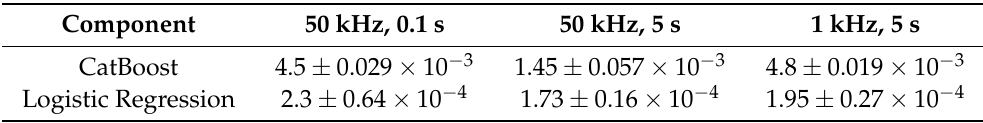
Table 8. The table shows the latencies of the machine learning algorithms for the optimised feature spaces of all the experiments. The tests are performed on the dataset fold 0. The times are reported in seconds as mean and standard deviation over 100